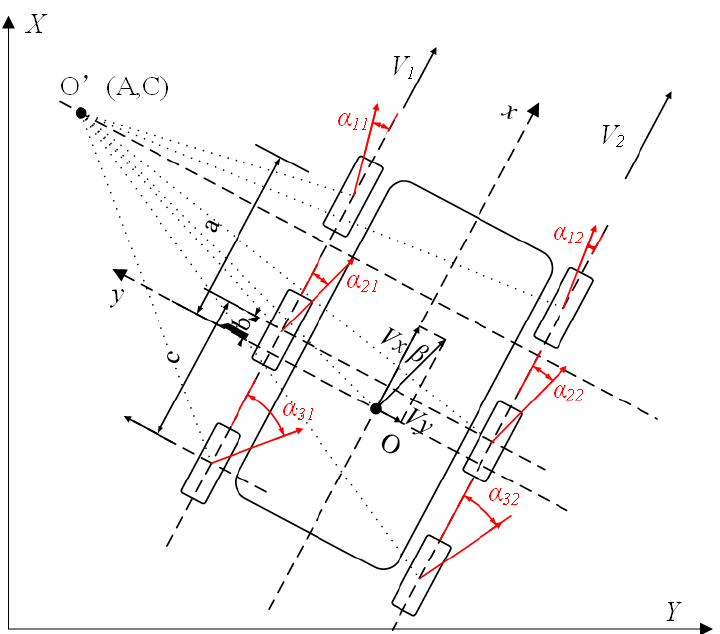
Figure 1. Kinematics diagram of the skid-steered wheeled UGV.